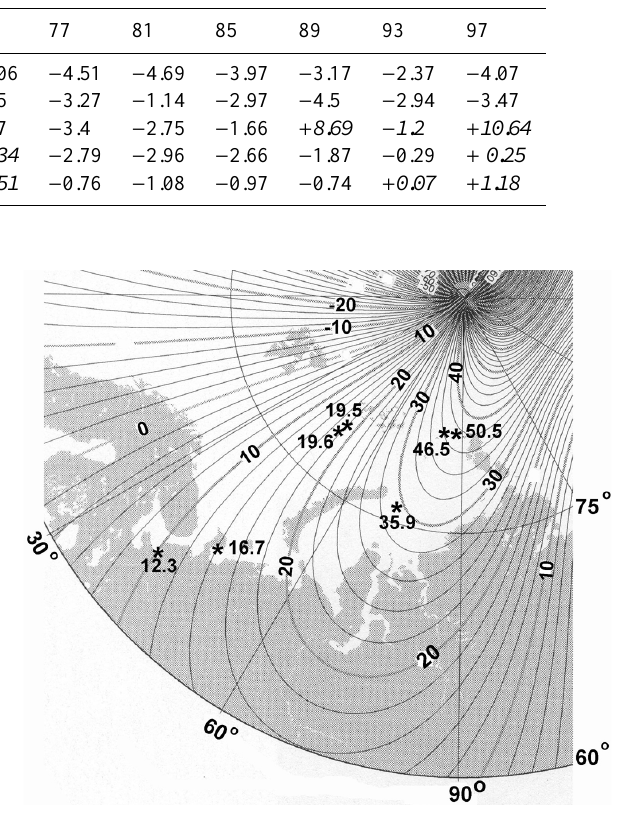
Figure 6. Chart of isogonic lines D for the epoch 1930 according to the IGRF-11 model showing points of magnetic declination mea- surements on board the